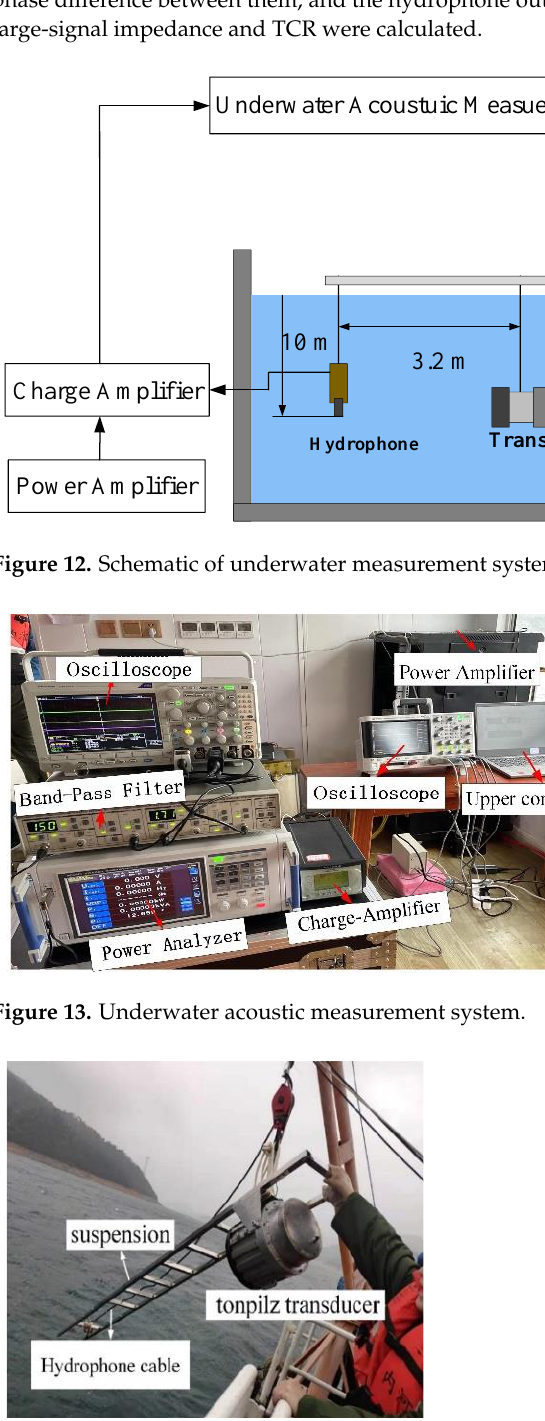
Figure 14. The transducer in water.